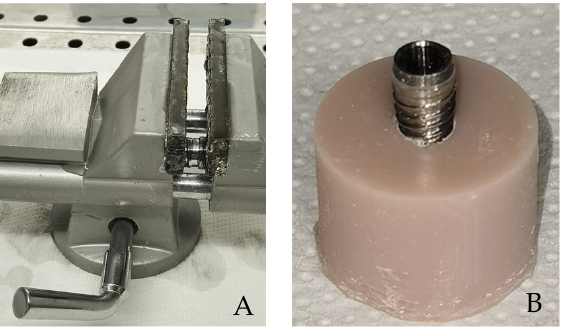
Figure 5. Implants fixation ( A ) Device used to fix the base with the implant; ( B ) Implant fixation on resin base.